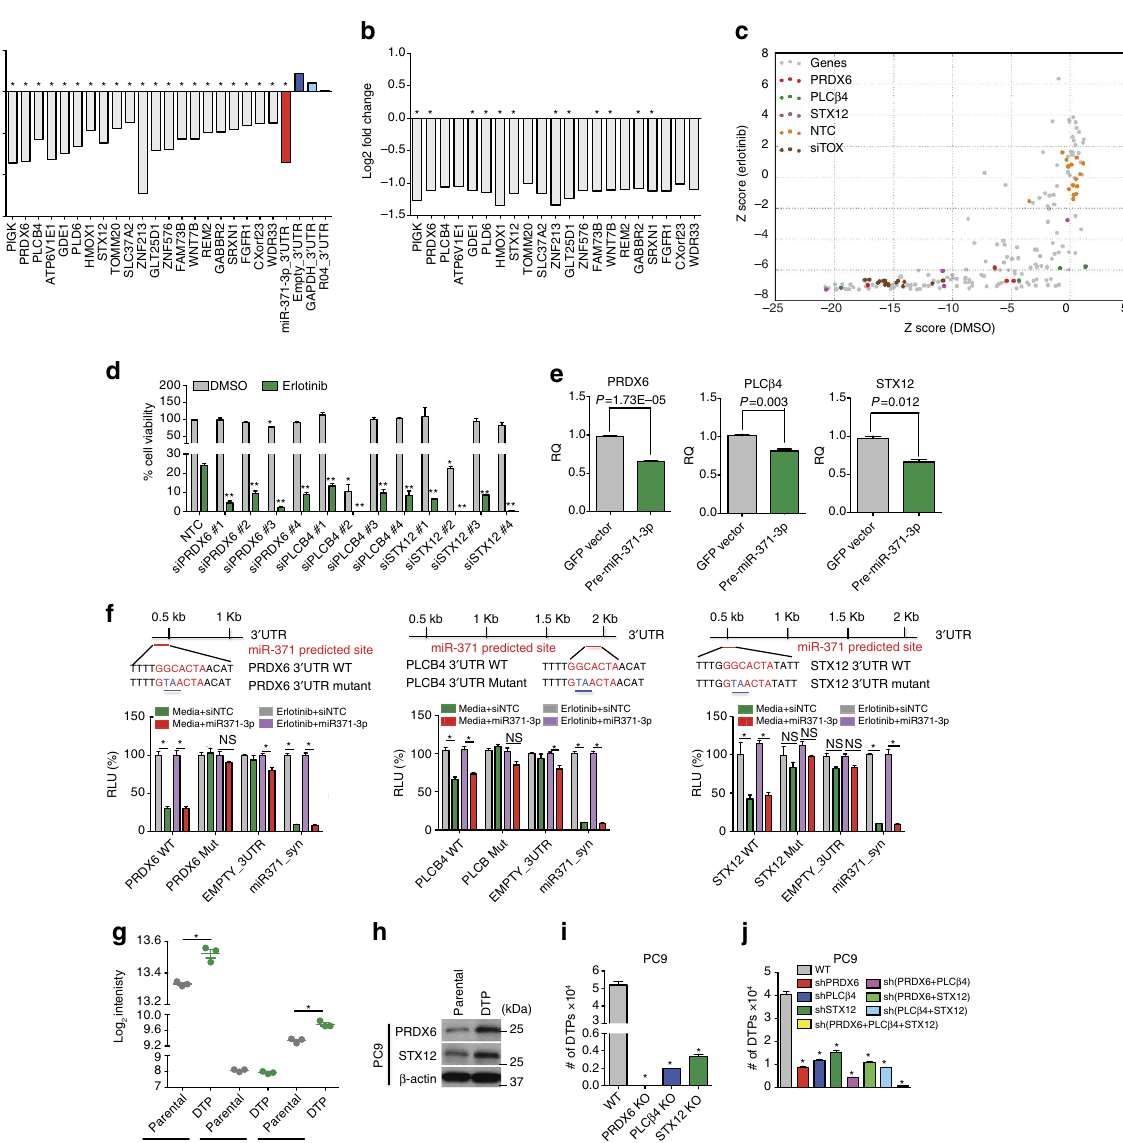
Figure 2 | Identification of relevant miR-371-3p targets. ( a ) Downregulation of luciferase by miR-371-3p upon erlotinib treatment from 3 0 UTR reporters corresponding to candidate miR-371-3p target genes * P o 0.05. ( b ) Microarray analysis of mRNA expression of miR-371-3p targets